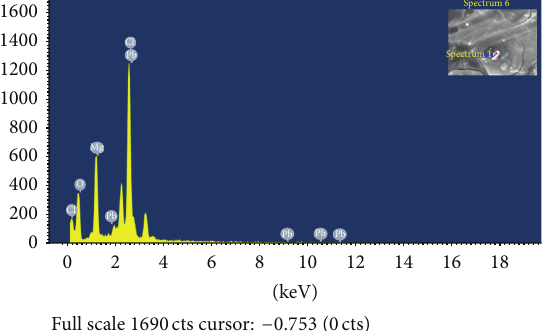
Figure 4: Energy dispersive X-ray spectroscopic (EDS) analysis for elemental composition of lead on cell surface of isolate B. licheniformis NSPA5. ∗ Inset-bacterial cell surface selected for EDS analysis.